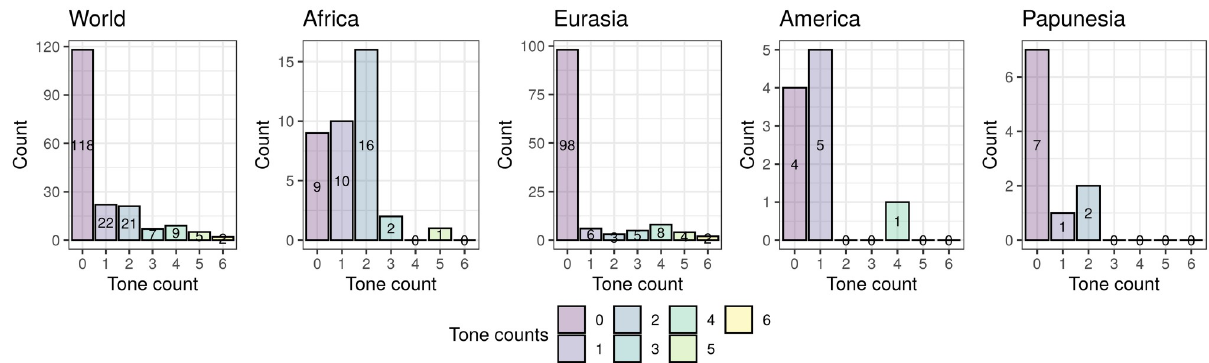
Fig 24. Distribution of tone counts across the full database (left-most panel) and by macroarea (the following 4 panels). Same conventions as in Fig 7.